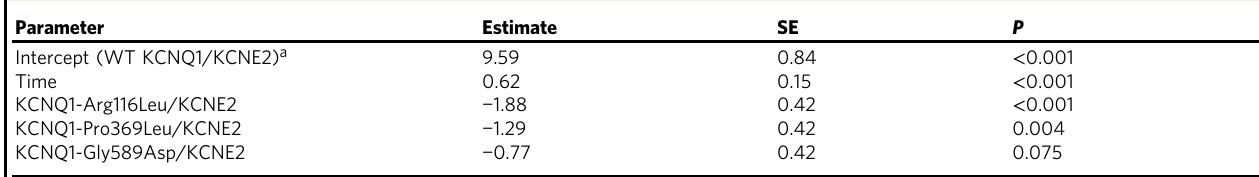
Table 3 Mixed linear regression model estimates for ACTH concentrations (ng/ml) measured in diluted medium samples from cells transfected with KCNQ1 and